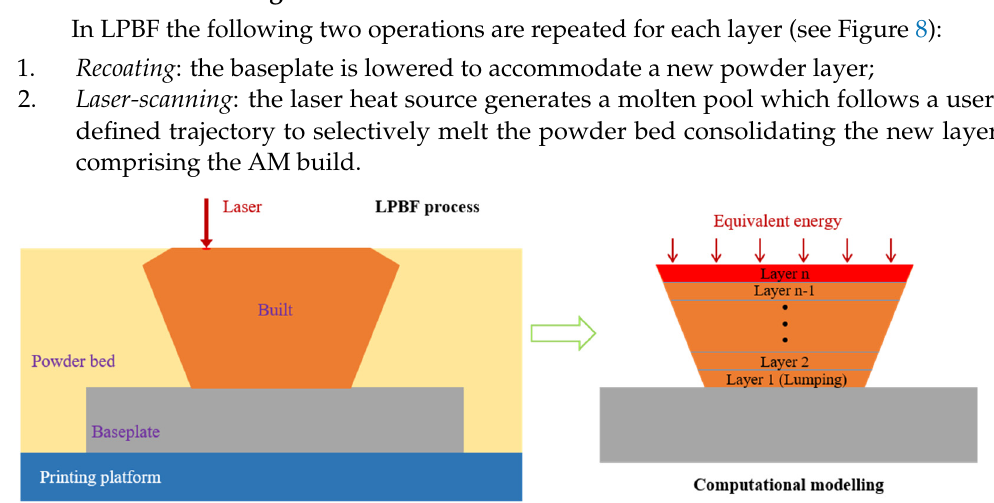
Figure 7. Contour-fills of the final warpage of the square thin-wall section with different wall-thicknesses: ( a ) 1 mm; ( b ) 2 mm; ( c ) 5 mm, respectively. ( d ) Maximum warpages recorded in the middle section.